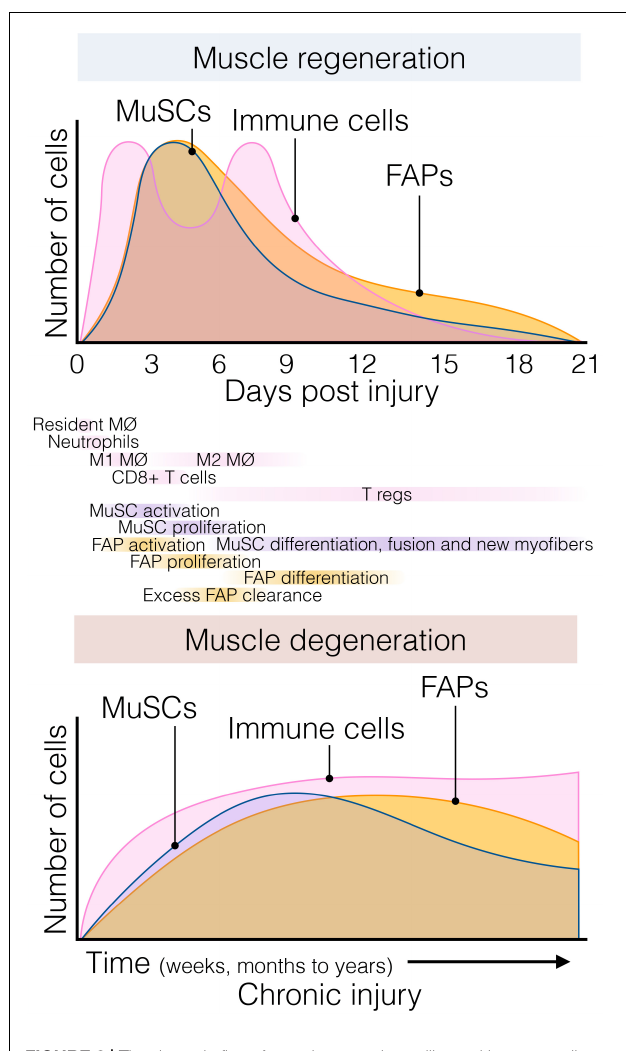
FIGURE 2 | The dynamic flux of muscle stromal, satellite and immune cells cellular flux responds to acute and chronic injury. (Top) Muscle regeneration is orchestrated by a synchronous array and flux of several muscle-resident and non-resident cells that interplay to maintain muscle structural integrity and function following injury. Followed the quick and early immune response of resident and non-resident macrophages, neutrophils, and eosinophils; FAPs and MuSCs rapidly activate and proliferate around day 3–5 post-damage. Here, FAPs provide constant support to myogenesis and actively participate in matrix remodeling. This process occurs in parallel with macrophage skewing, and the presence of regulatory Ts-cells follows it. Later, their lineage cells start committing and differentiating. By around day 21 post-injury, injured muscles have regenerated, and damage-induced cellular flux returned to steady-state levels. (Bottom) Chronic muscle injury is characterized by progressive muscle degeneration and a dysregulated burst of immune, MuSC, and FAP cells, among other cell types (not shown here for simplification purposes). Several neuromuscular disorders and muscle diseases are often characterized by chronic cycles of muscle degeneration and regeneration. However, there is less knowledge and characterizations about these cellular compartments’ behavior compared to single rounds of injury. Aging and prolonged disease states cause MuSC exhaustion, and FAPs seem to respond similarly. To date, Duchenne muscular dystrophy (DMD) represents the better-characterized muscle disease, but it is unknown whether this gained knowledge can be applied to other disease settings. Tregs, muscle regulatory T-cell; FAP, fibro-adipogenic progenitor; MuSC, muscle stem cell; MØ,